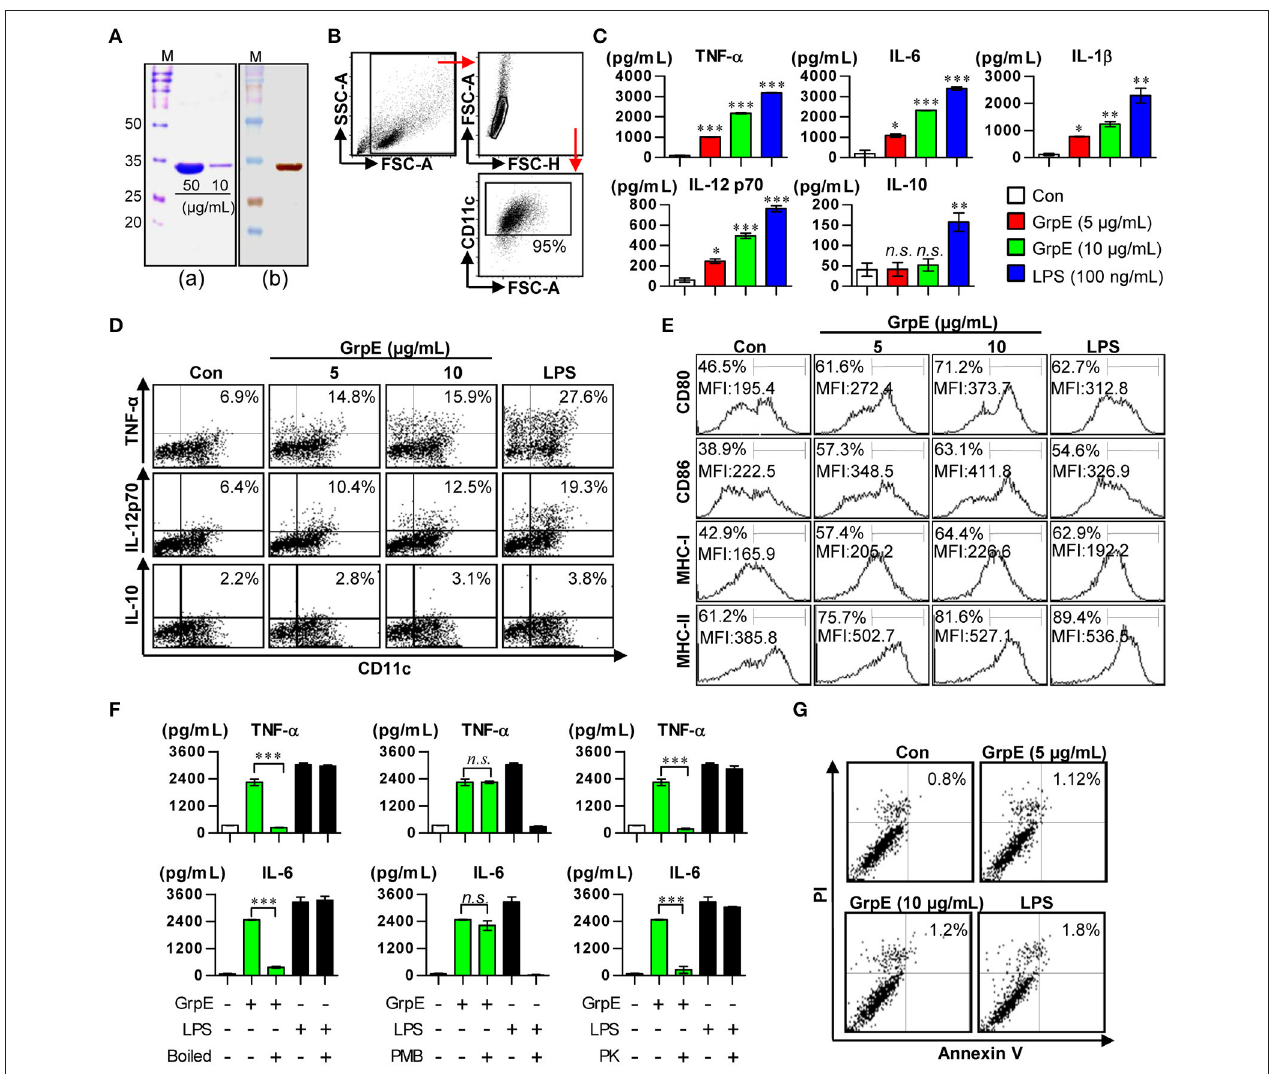
FIGURE 1 | Preparation of recombinant GrpE and analysis of primary characteristics of DC maturation by GrpE treatment. (Aa) SDS–PAGE analysis of purified GrpE by Ni-NTA (M, markers; Bands, GrpE loading amount). (Ab) Western blot analysis of purified GrpE (10 µ g) using mouse anti-His Ab. (B) Gating strategy of purified CD11c + DCs. (C) Cytokine production by GrpE-treated DCs. DCs were generated by stimulating magnetic bead-purified immature DCs with LPS (100ng/mL), GrpE (5 or 10 µ g/mL) for 24h, followed by ELISA for IL-12p70, TNF- α , IL-6, IL-1 β , and IL-10 production. (D) Analysis of TNF- α , IL-12p70, and IL-10 expression in DCs by intracellular cytokine staining after 12h at 37 ◦ C in the presence of GolgiPlug (1 µ g/mL). One representative plot from three independent experiments is shown. (E) CD11c + DCs were stained with anti-CD80, CD86, and MHC class I and II mAb and the expression levels of surface molecules were measured. One representative plot from three independent experiments is shown. (F) GrpE and LPS were heated for 1h at 100 ◦ C (left panels) or digested with PMB (middle panels) or PK (right panels) before adding it to DC culture, as described in the section Materials and Methods. After 24h treatment, TNF- α and IL-6 levels in the supernatant of DCs were analyzed using ELISA. These results are expressed as the mean ± SD ( n = 3 samples) of representative result in three experiments (* p < 0.05, ** p < 0.01, or *** p < 0.001). (G) DCs treated with GrpE or LPS were harvested 24h later. The DCs were stained with anti-CD11c, annexin V, and PI and analyzed by flow cytometry. One representative plot from three independent experiments is shown. Con denotes untreated